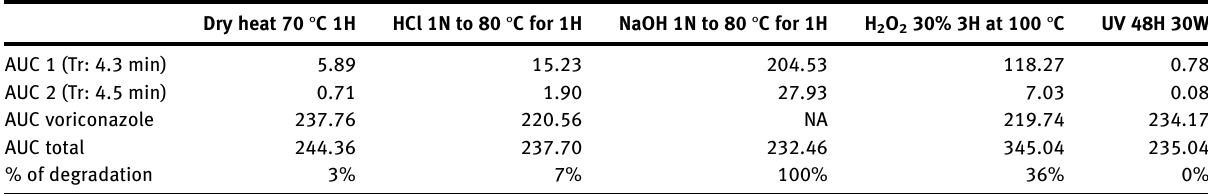
Table  : Table of the degradation study.